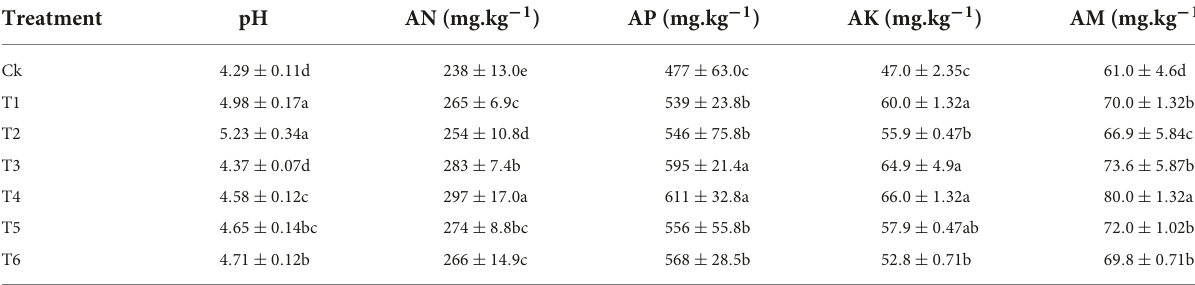
TABLE 1 Changes of soil pH and mineral element content after application of biochar for 3 years. Treatment